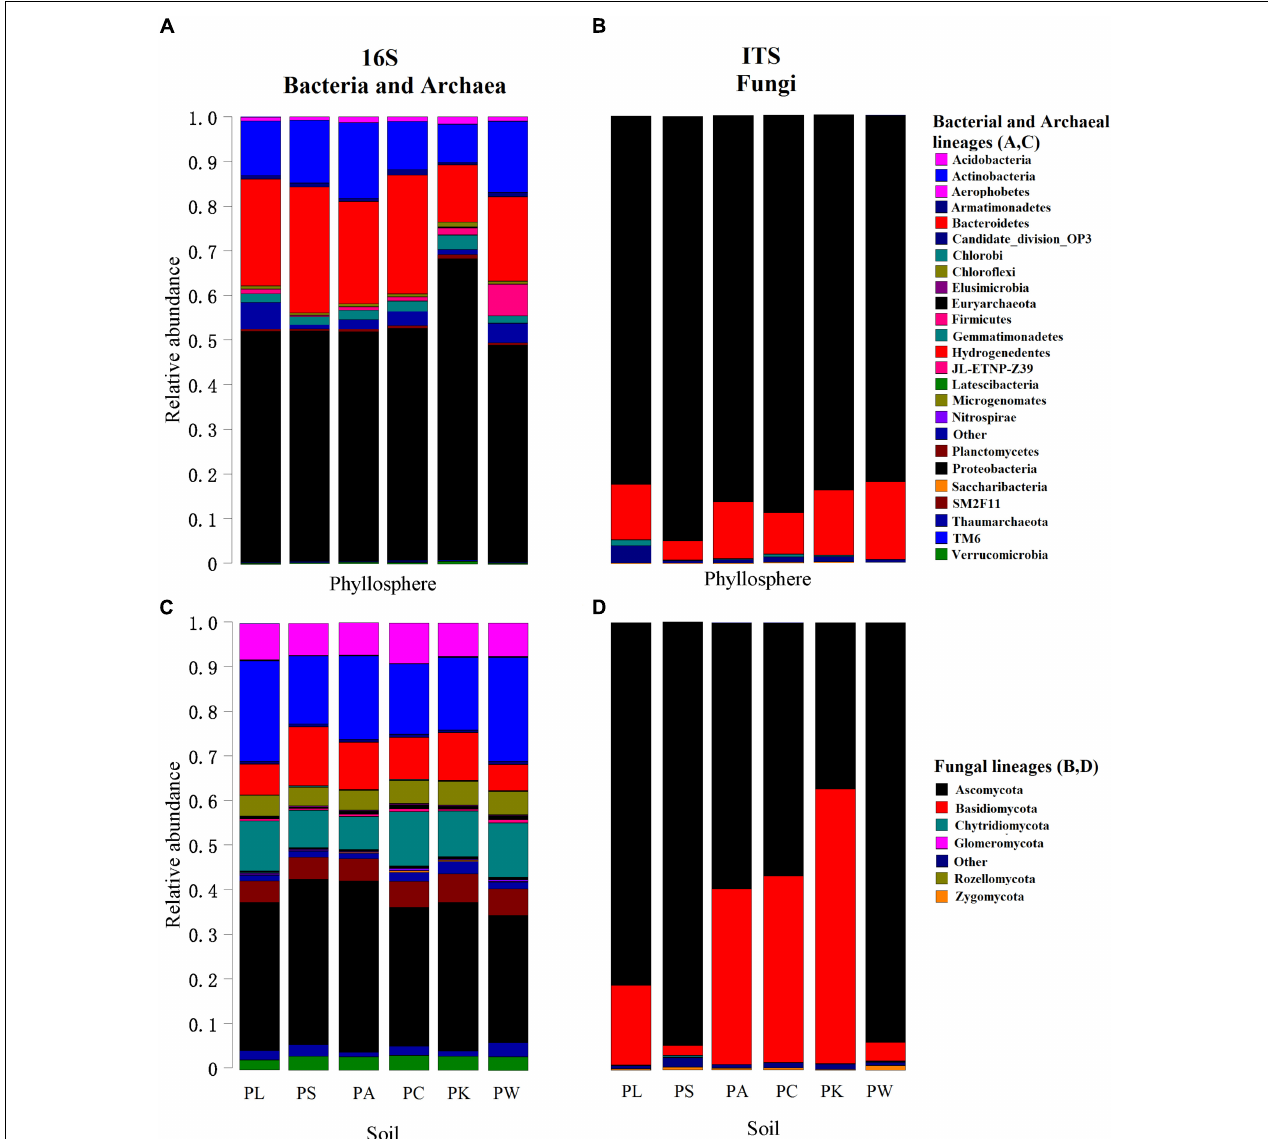
FIGURE 1 | Relative abundances of major bacterial/archaeal (A,C) and fungal (B,D) phyla for each leaf or root sample. The phyla are shown in alphabetical order.